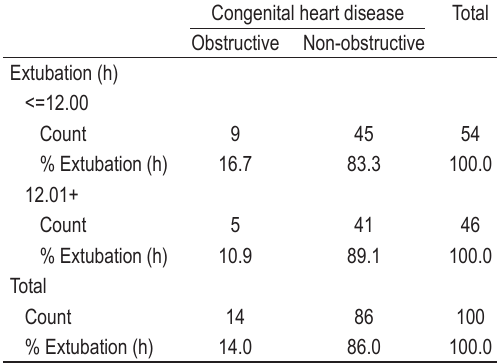
TABLE 2. Time of the extubation and type of the congenital heart disease Congenital heart disease